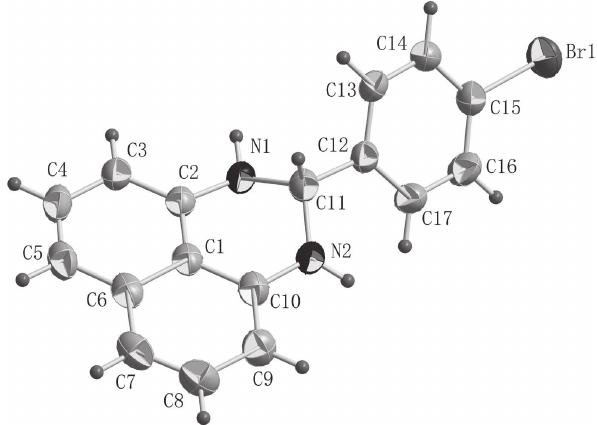
Table 2: Fractional atomic coordinates and isotropic or equivalent isotropic displacement parameters (Å 2